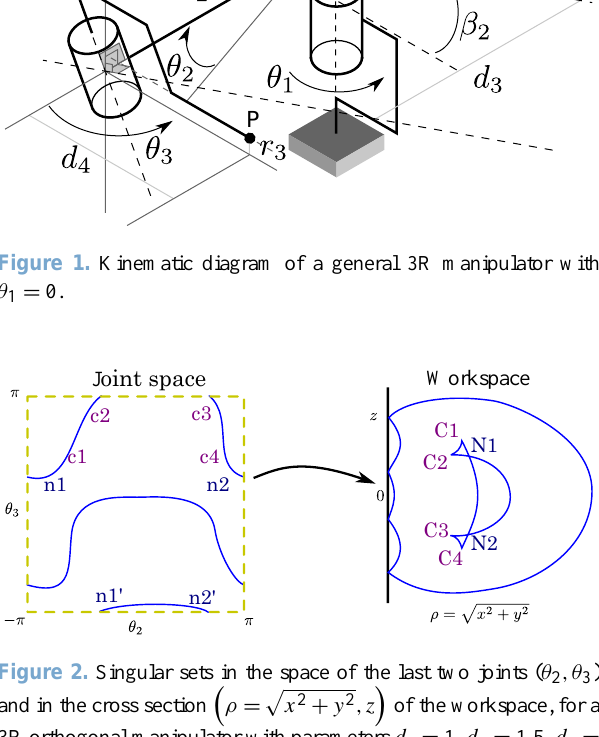
(cid:16) (cid:17) p ρ = x 2 + y 2 ,z of the workspace, for a